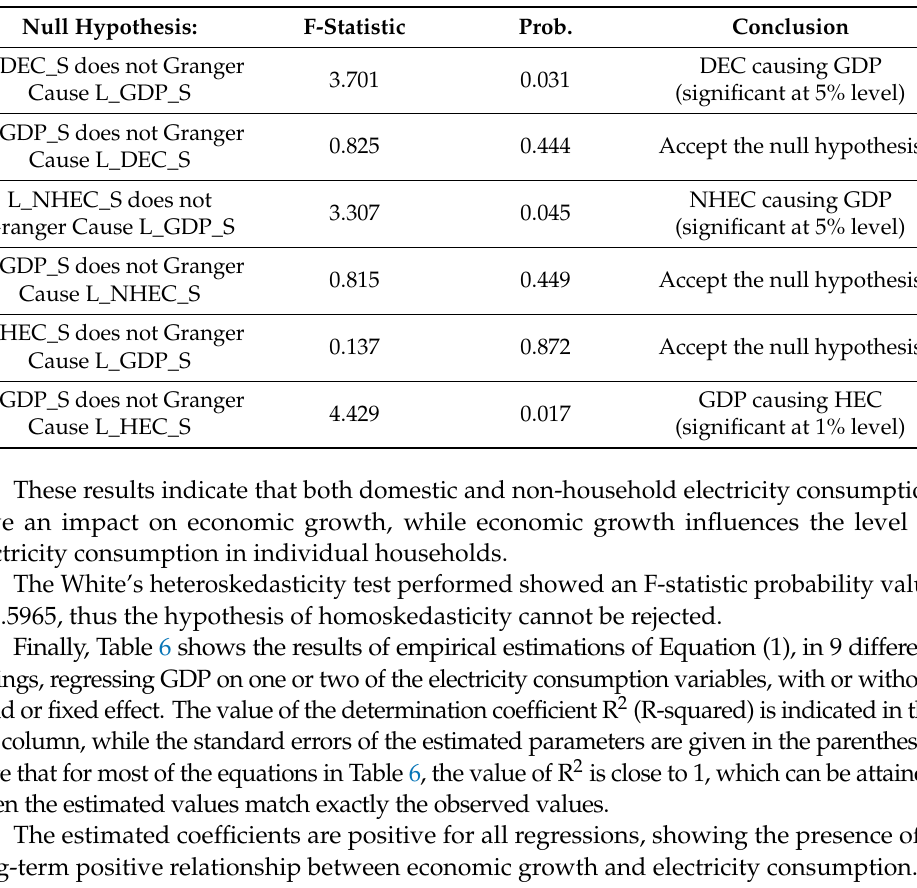
Table 5. Granger causality